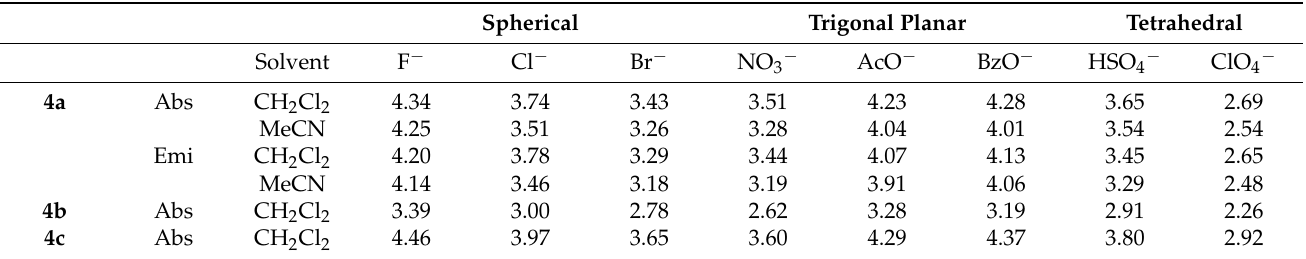
Table 3. Association constants (log K ass ) a of (thio)ureas 4a – 4c determined by UV–Vis absorption and emission at 25 ◦